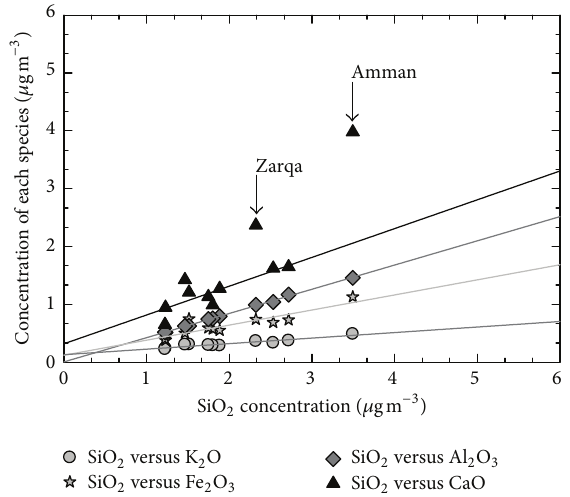
Figure 3: Comparison of dust oxides between sampling sites (both Amman and Zarqa data points were excluded from the CaO and SiO 2